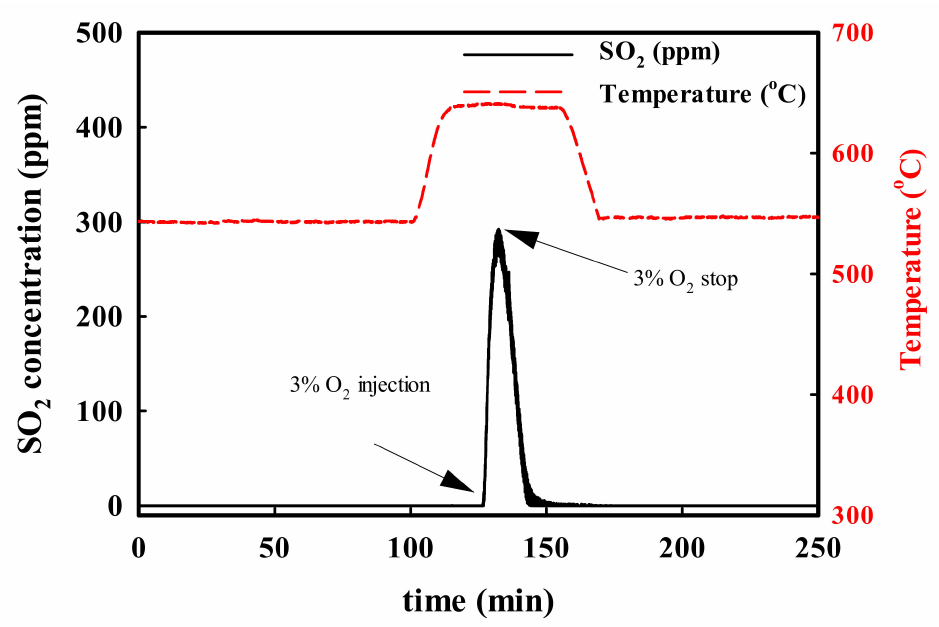
Figure 2. Effect of oxygen in the sorbent itself on the SO 2 generation. Secondly, the formation of ZnSO 4 was analyzed using X-ray diffraction (XRD) to deter- mine whether the SO 2 generation was from a side reaction of the desulfurization. Figure 3 shows the XRD patterns of the sorbents (SC-229TD, before and after the first desulfuriza- tion, after the first regeneration, and after the second desulfurization). The desulfurization was conducted at 550 ◦ C and 4000 ppm H 2 S. Then, the sorbent was regenerated at 650 ◦ C under a 3% O 2 condition. As shown in the XRD patterns, the ZnO peak was mainly assigned in the fresh sorbent, and some NiO peak was found. Al- or Si-based compounds used as support were not detected. In the case of the sulfided sorbent, unreacted ZnO, sulfided ZnS, and NiS were found in the XRD patterns. The SiO 2 peaks identified in the XRD patterns were the inert material (sand) mixed with sorbent. In the sorbent after regeneration, the ZnS and NiS peaks disappeared as they existed as ZnO and NiO, which were in the same phase as before the desulfurization reaction. From these results, it can be concluded that the ZnSO 4 phase was not produced by side reactions during the desulfur- ization and regeneration, which leads to the conclusion that the generation of SO 2 gas was not by ZnSO 4